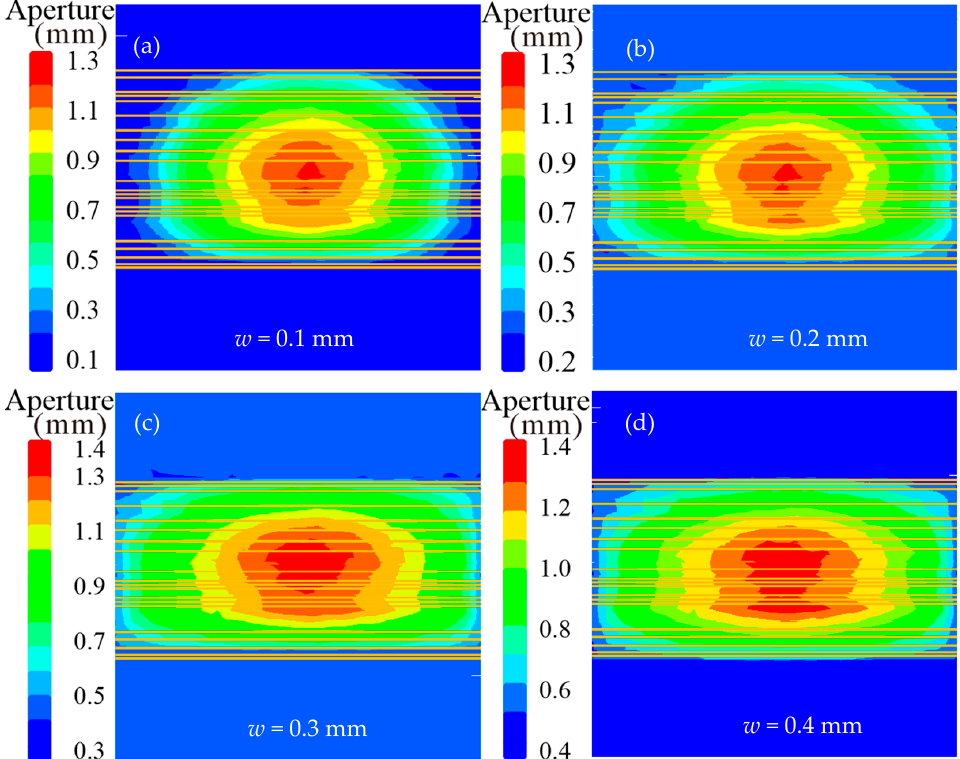
Figure 15. Fracture geometry and aperture distribution in different cases, with the bedding aperture of ( a ) w = 0.1 mm, ( b ) w = 0.2 mm, ( c ) w = 0.3 mm, and ( d ) w = 0.4 mm.